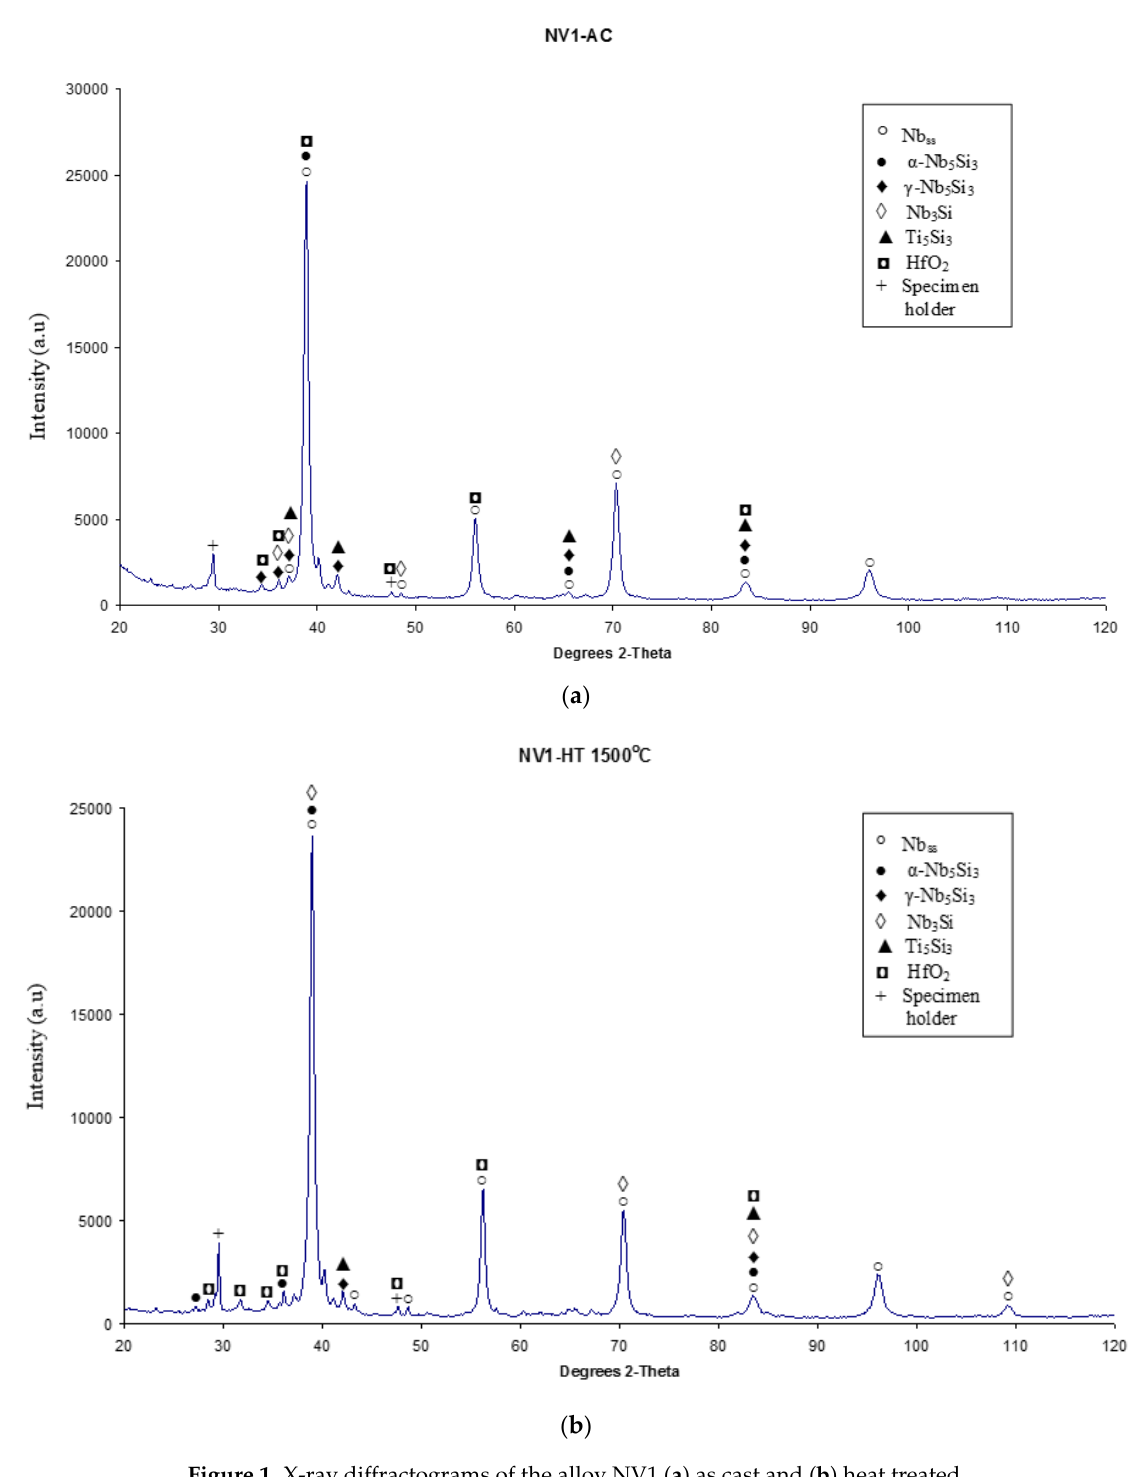
Figure 1. X-ray diffractograms of the alloy NV1 ( a ) as cast and ( b ) heat treated. For example, in Figure 2a,b, the areas of darker contrast near the Nb 5 Si 3 silicide are Ti rich, and the brighter contrast Nb 5 Si 3 grains are Hf rich (see below). The Ti-rich Nb 5 Si 3 , regarding its high Ti concentration, corresponded to the Ti-rich Nb 5 Si 3 reported in other Ti-containing RM(Nb)ICs [35,36]. The Ti-rich Nb ss was observed only in the top and bot- tom of NV1-AC. In Table 2, the Nb 5 Si 3 is also designated as Ti- and Hf-rich Nb 5 Si 3 , owing to its high Hf and Ti contents (see below).